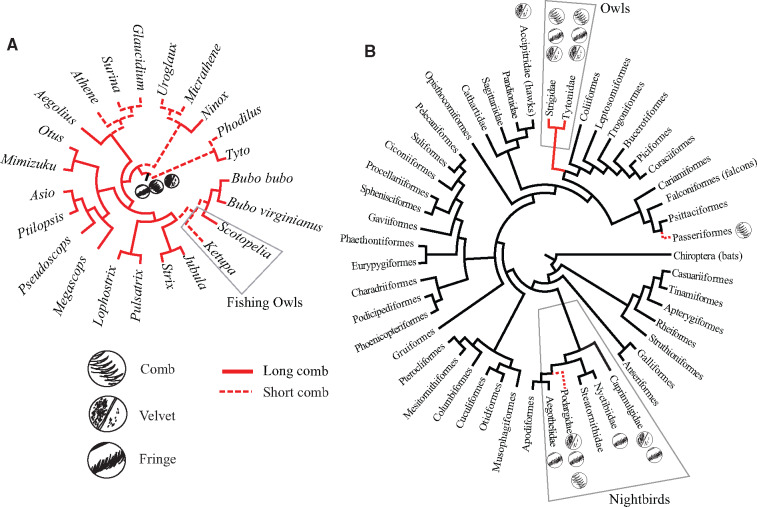
Phylogenetic distribution of dorsal velvet, fringed vanes, and leading-edge comb. A) Phylogeny of major owl genera (modified from Wink et al. 2009). Red: leading-edge comb extends >1 mm from surface of P10 (as measured at the midpoint of the comb) in at least one species within each clade. Red dash: leading-edge comb present but extends <1 mm at midpoint of the comb. B) within extant flying vertebrate clades (phylogeny from Prum et al. 2015). Clades with at least one species with a character are marked (i.e., out of ∼5000 passerine species, since the two Stelgidopteryx spp. have a comb-like structure, the entire clade is indicated as short comb present). Black: no data; true absence data are lacking.